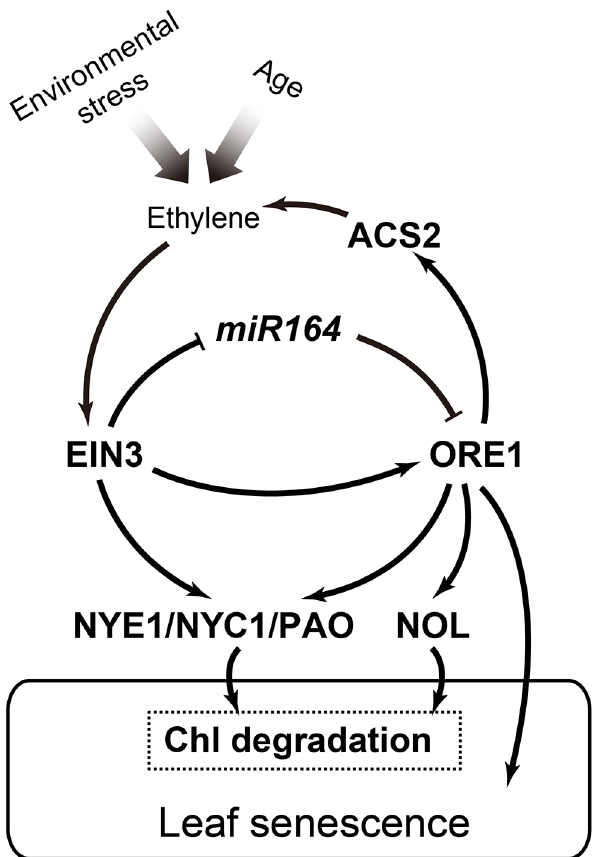
feed-forward loop that involves EIN3 and ORE1 in regulating ethylene-mediated chl degradation. EIN3 directly represses the transcription of miR164 , which negatively regulates ORE1 at the post-transcriptional level. Meanwhile, EIN3 can directly bind to the ORE1 promoter and induce ORE1 transcription. Three CCGs , NYE1 , NYC1 , and PAO , are the direct targets of EIN3. As a transcription factor downstream of EIN3, ORE1 shares these 3 common direct targets with EIN3. However, ORE1 also has its own distinct target, NOL , during the regulation of chl degradation. The broad range of expression of CCGs leads to chl degradation, the